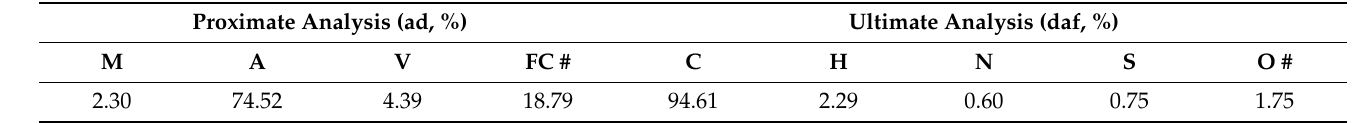
Table 1. Proximate and ultimate analyses of the coal gasification fine slag.